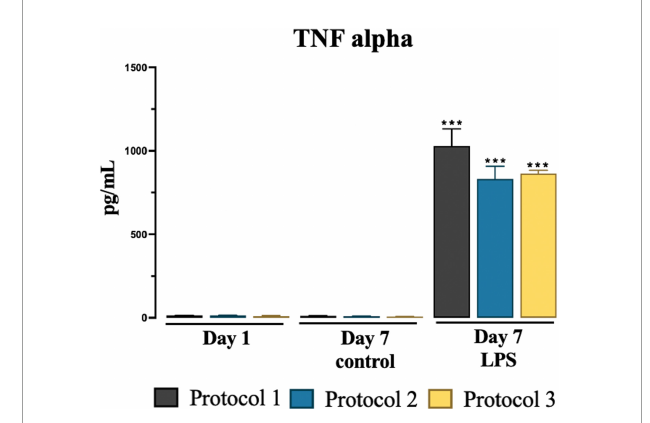
FIGURE7 Evaluation of cytokine TNF-alpha secretion. Graphical representation of TNF-alpha conc. at day 1, day 7 for control and LPS treated cells. Data are presented as mean ± SEM; N = 3. *** p < 0.001 compared to the control day